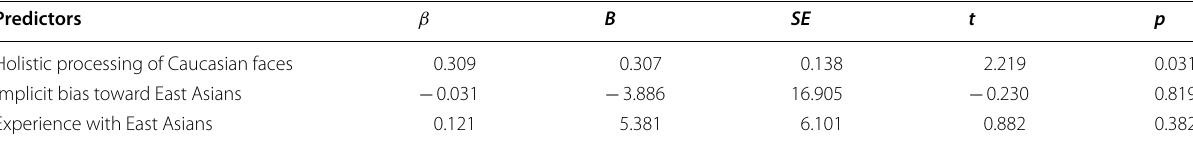
Table 5 Results of the multiple regression analyses on the congruency effect (∆RT: RT in incongruent trials minus RT in